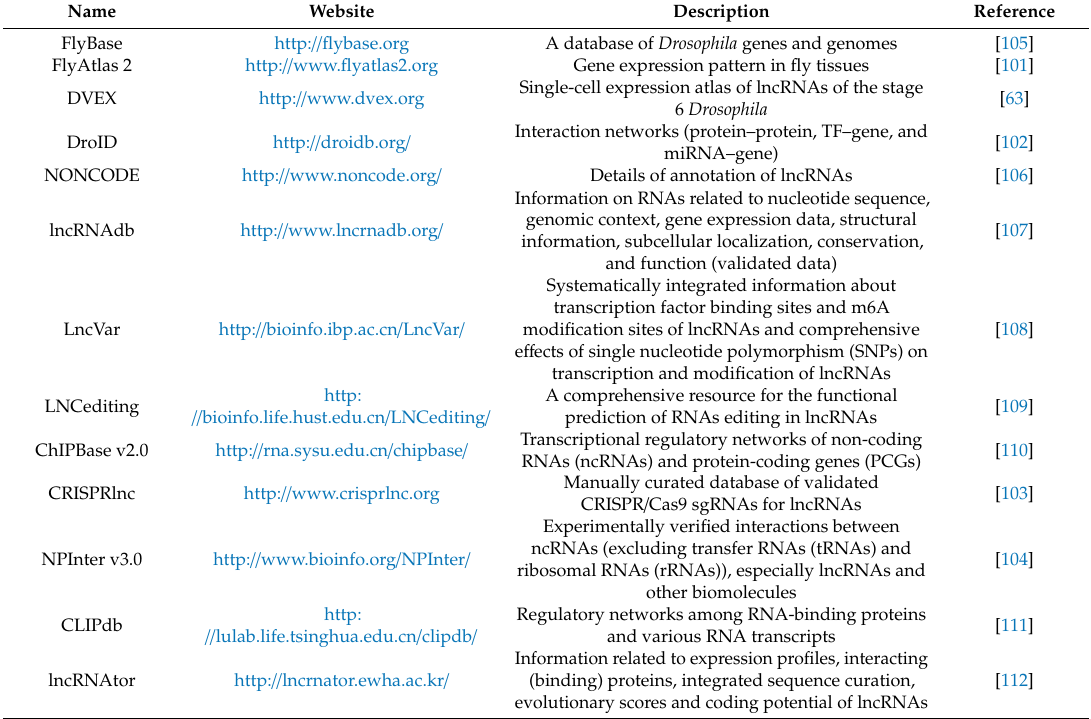
Table 2. Drosophila lncRNA-related